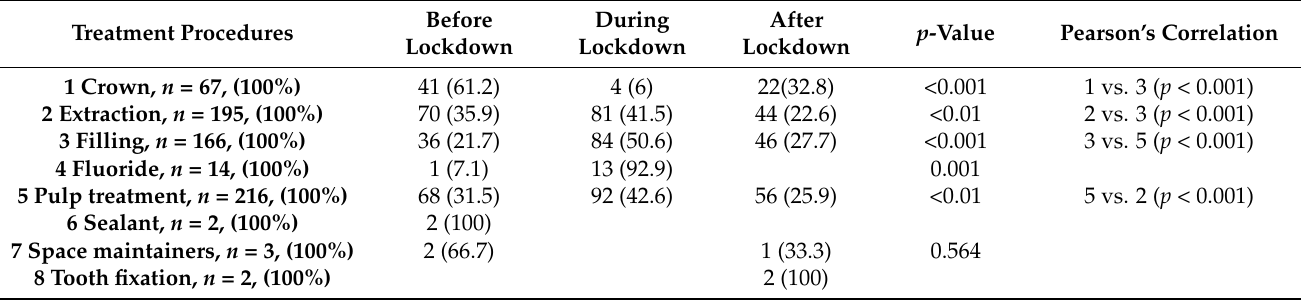
Figure 5. The percentages of pediatric patients treated with medication or dental procedures before, during, and after the lockdown (*** statistically significance at p < 0.001). Table 4. Comparison and correlation among the treatment procedures of pediatric patients before, during, and after the lockdown.